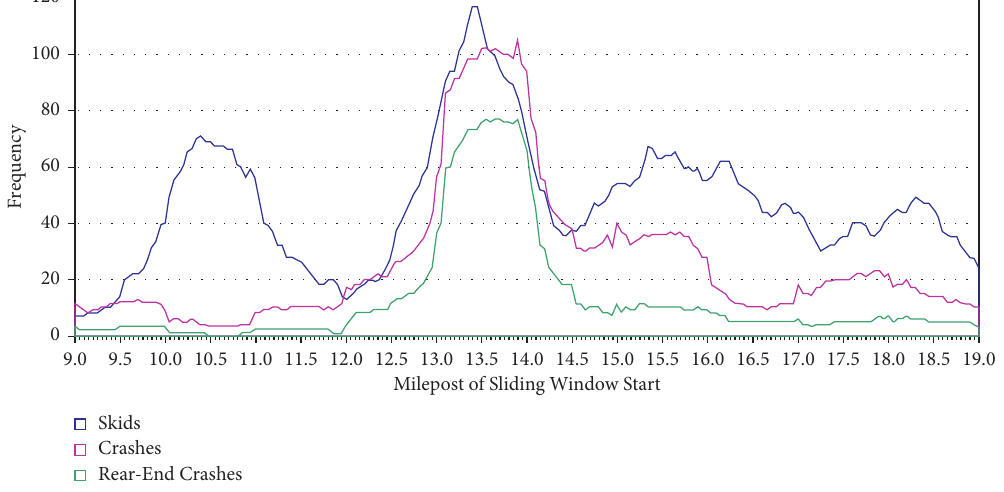
Figure 15: Sliding windows crash/skid frequency on Interstate 80 eastbound (1.0-mile windows, 0.05-mile step).